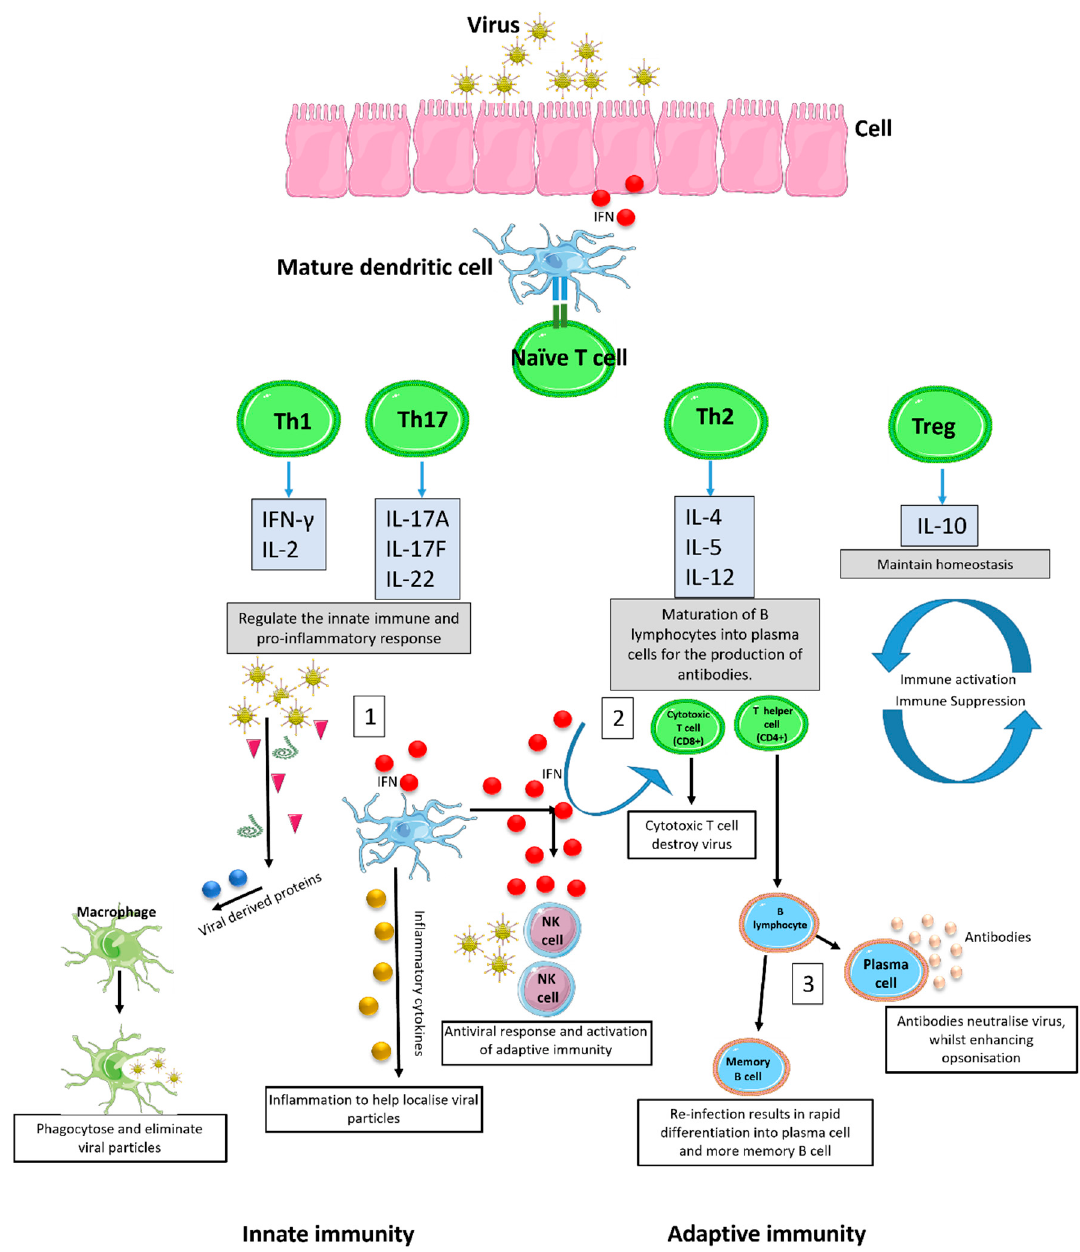
Figure 2. Immune response to viral infection. Viral infections elicit an immune response by first activating the innate immune system. Infected cells release IFN and pro-inflammatory cytokines that activate natural killer cells to destroy the viral infection. Simultaneously, infected cells express viral antigens on the cell surface, activating professional APCs such as dendritic cells (DCs). DCs interact with viral antigens through pattern recognition receptors for their maturation and in turn switch naïve T-cells into mature T-cells (Th1, Th17, Th2, and Tregs) that regulate both the innate and adaptive immune system. The innate response regulates a Th1 driven pro-inflammatory cascade, resulting in the recruitment of immune cells for rapid eradication of the infection (1). The adaptive immune system stimulates the differentiation and expansion of T lymphocytes into specific subsets, better known as cytotoxic T-cells (CTLs, CD8+) and T helper cells (CD4+). CTLs are responsible for the direct killing and eradication of viral particles and infected cells (2), whilst T helper cells recruit immune cells and stimulate the differentiation of B lymphocytes. B lymphocytes are responsible for the viral specific rapid response and long lasting immunological memory against recurring infection through the production of two subsets known as plasma cells and memory B-cells. Differentiation into plasma cell results in the production of virus specific antibodies for the neutralisation of viral progeny, the activation of the complement cascade, and antibody mediated